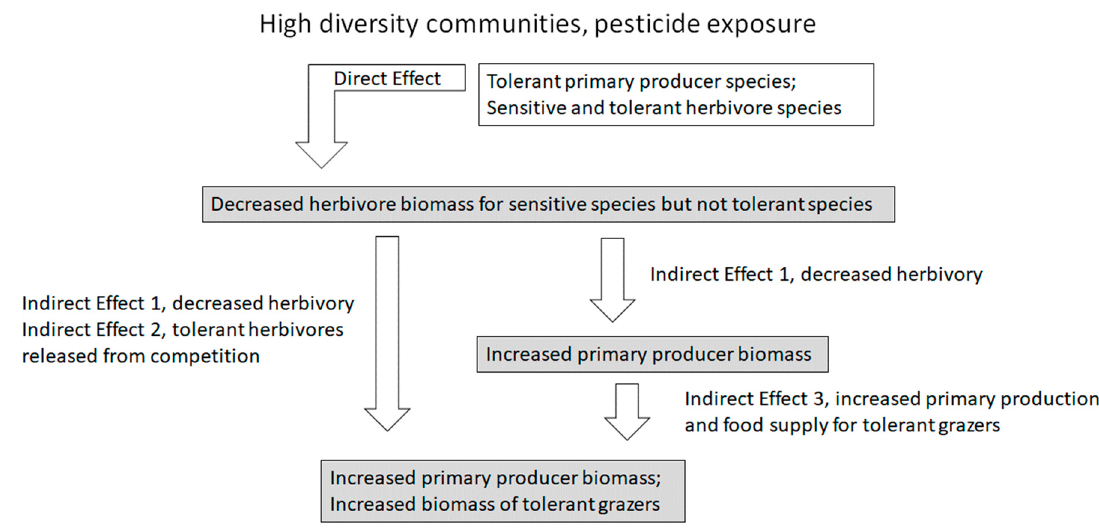
Figure 4. One scenario for indirect effects in a diverse community with relatively sensitive and relatively tolerant herbivores species exposed to a pesticide. In this example, indirect effects may be mild but will be difficult to predict, and they will vary depending on species composition and with changes in environmental conditions. Ecosystem state changes caused by direct and indirect effects are described in shaded boxes. This figure was based on a figure published in [1], page number 217, Copyright Elsevier. Indirect e ff ects may be of a greater magnitude than the direct e ff ects of contaminants